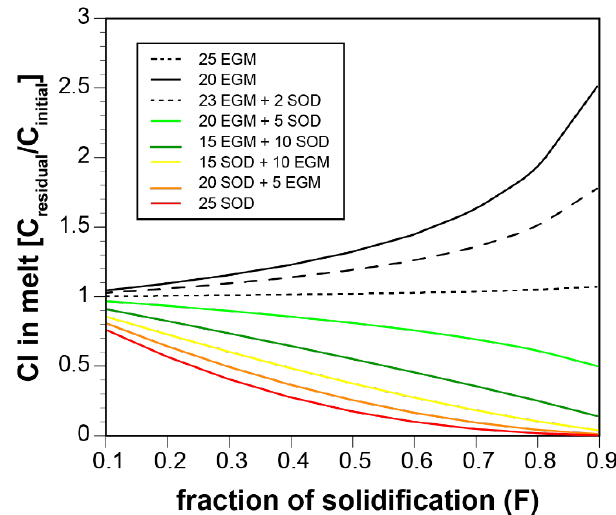
Figure 6. Fractional crystallisation model illustrating the effects of sodalite (SOD) and eudialyte-group mineral (EGM) removal on the Cl concentration in the residual magma (expressed as C residual /C initial ) depending on the fraction of solidification (F).